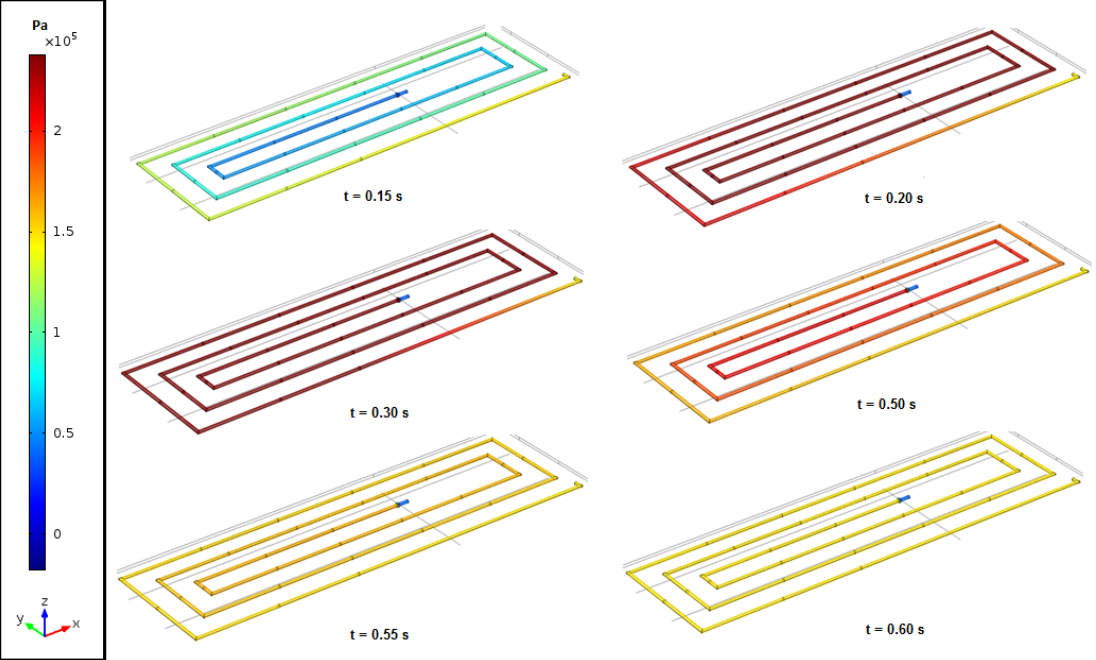
Figure 20. Wave propagation pressure contours on the fluid–structure interface.